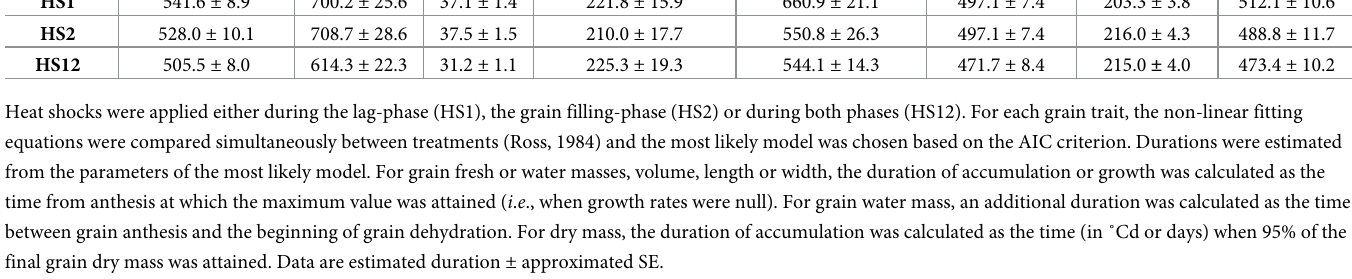
Overall, heat shock treatments tended to decrease maximum estimated values of traits by decreasing the durations of the various accumulation/growth processes that were partly com- pensated by increased rates of growth. Moreover, it is also worthwhile that for most of the grain growth processes, HS12 treatment was not more detrimental to grain growth than the HS1 or HS2 treatments. Table 4. Estimated duration of growth of basal grains from the central spikelets of wheat plants exposed to heat shocks. Treatment Fresh mass